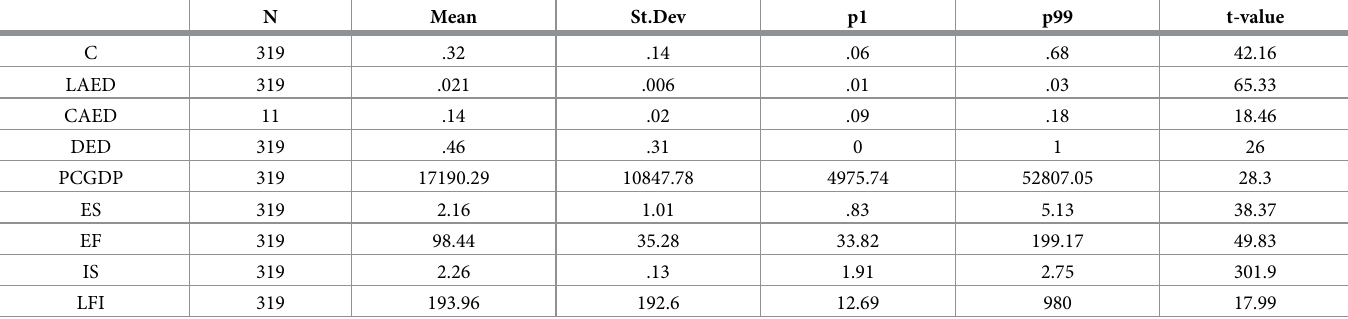
Table 3. Descriptive